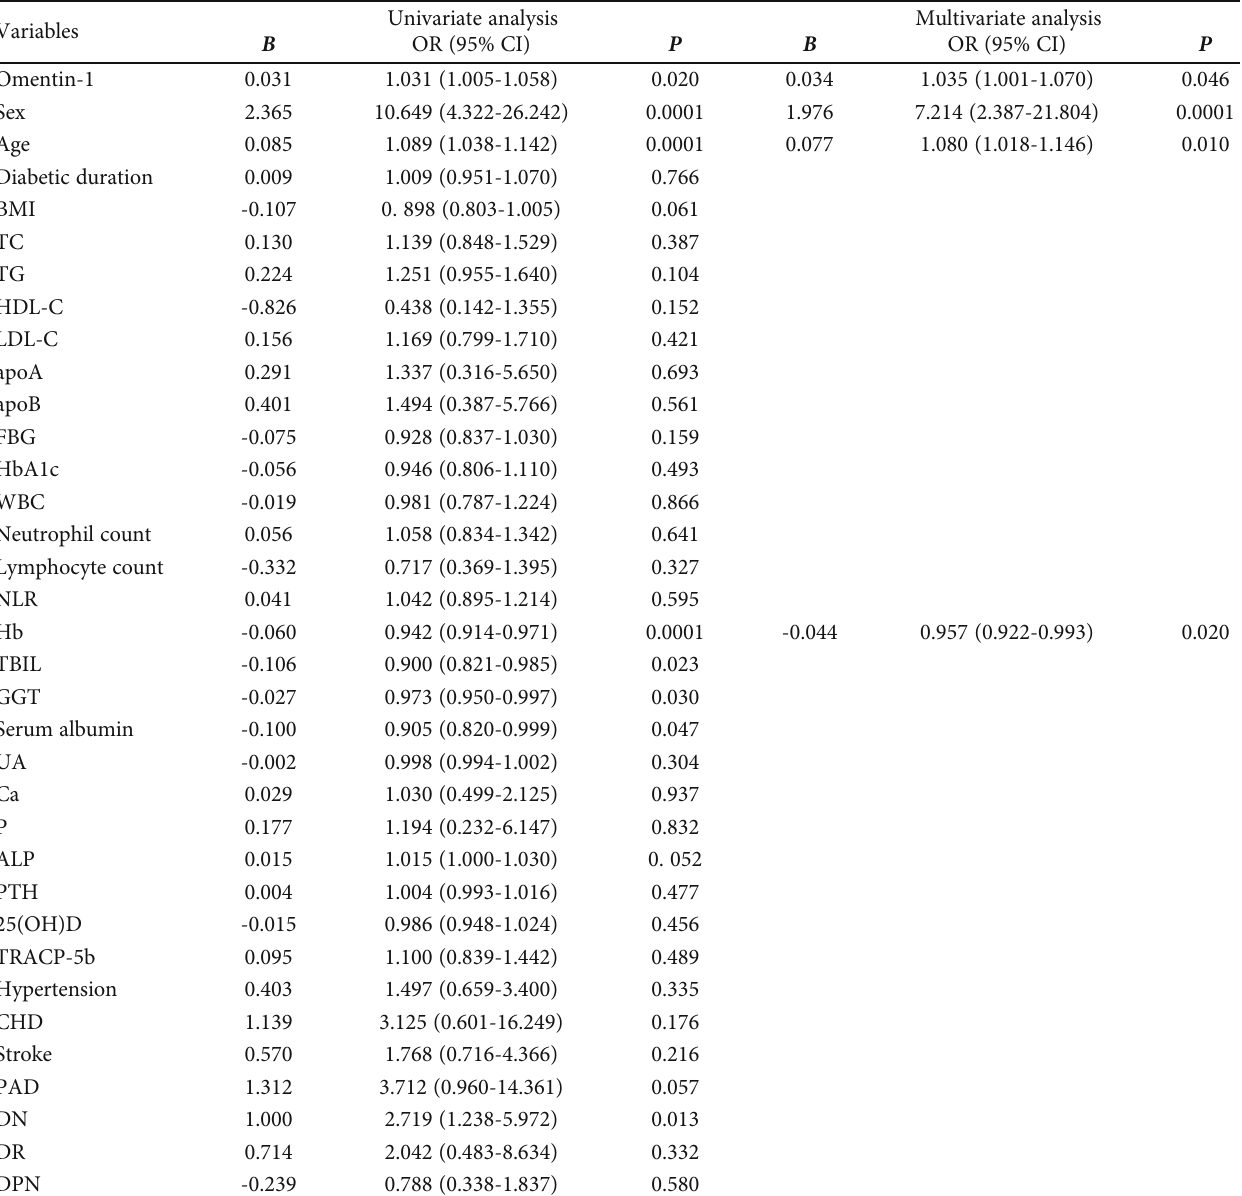
Table 3: Binary logistic regression analyses of variables contributing to osteoporosis in patients with T2DM.